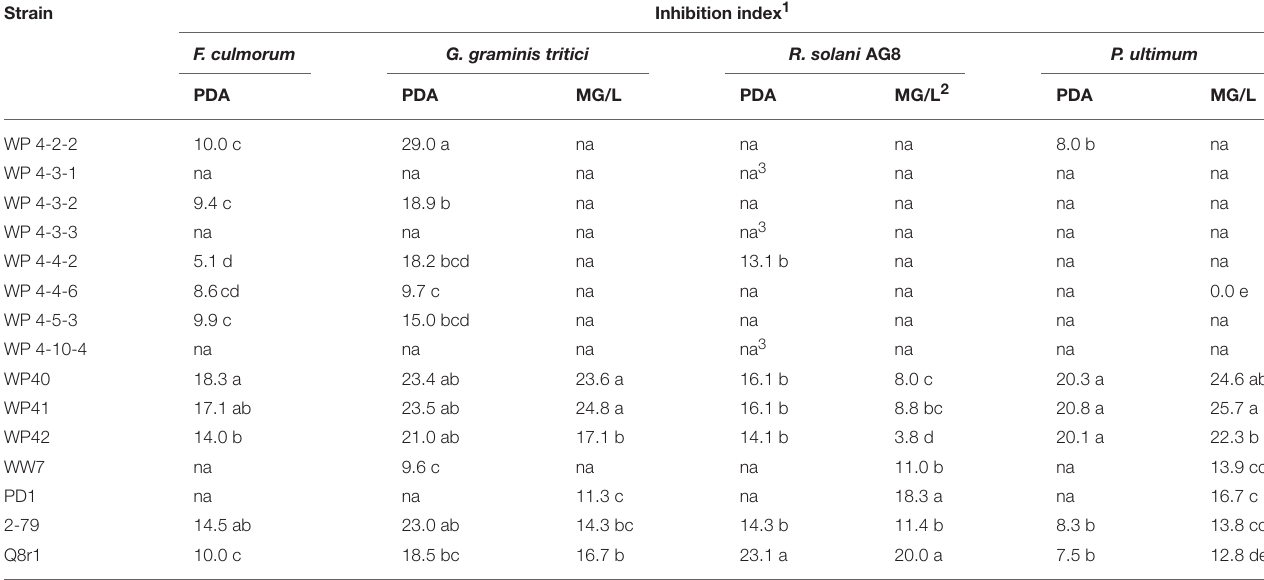
TABLE 3 | In vitro inhibition of four soilborne fungal pathogens by bacterial strains on potato dextrose agar (PDA) and mannitol/glutamate agar (MG/L) . Strain